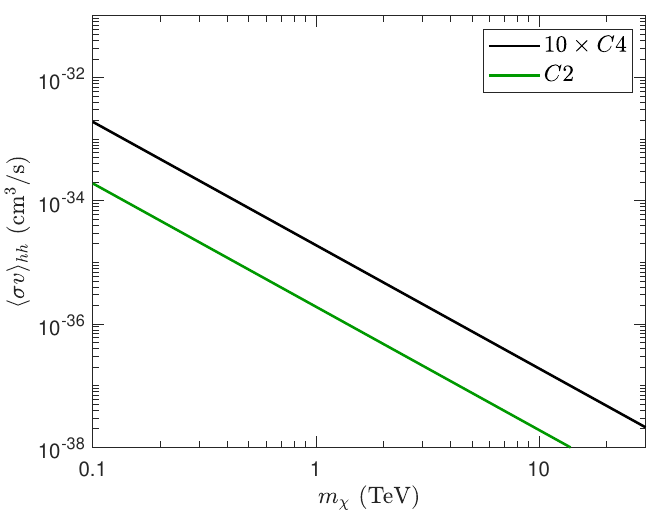
Figure 12. Annihilation cross-section into hh pair for complex doublet (green) and quadruplet (black) models. Two lines almost fully overlap, so the C4 line is scaled by ten. The value of scalar couplings are set to λ 0 / Λ = 10 − 8 GeV − 1 and λ c / Λ = 3 × 10 − 6 GeV − 1 which is identical to the previous plots in this